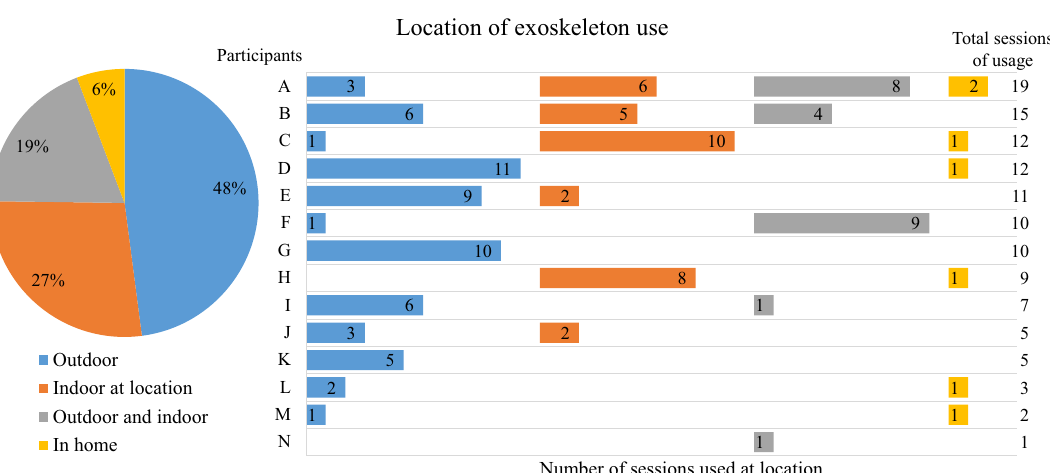
Figure 3. Location of exoskeleton use during the period of home and community